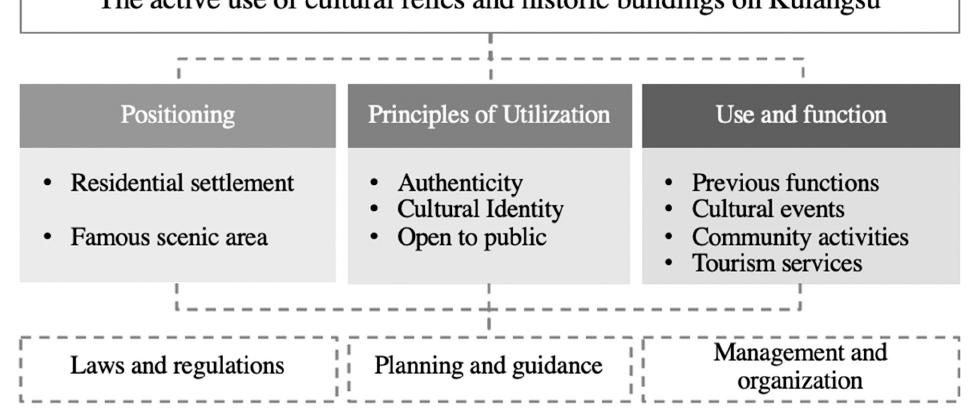
Figure 3. The framework of the restoration of historic buildings on Kulangsu (made by author).